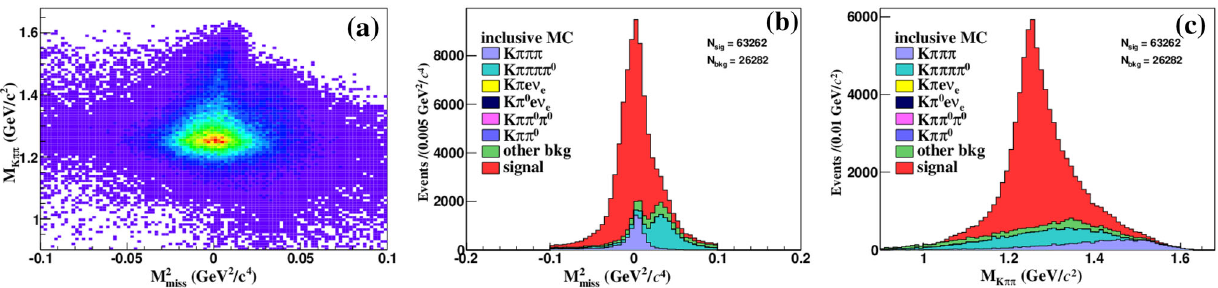
/ M K ππ distribution of the semi-leptonic candidate miss